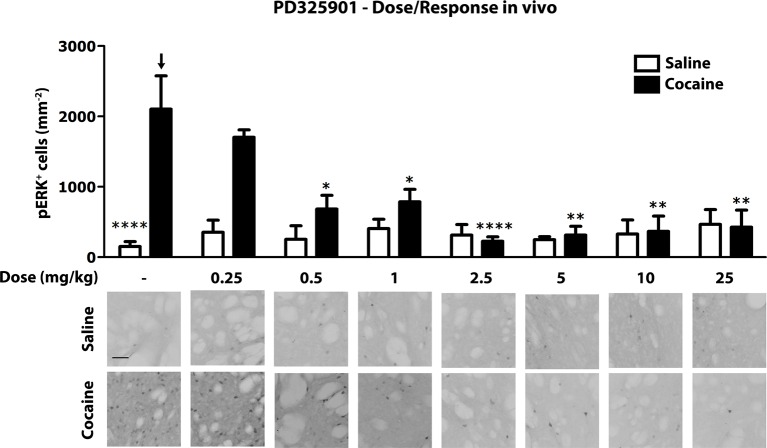
Dose response curve of MEK inhibitor PD325901 on ERK phosphorylation in vivo.Different doses of PD325901 were administered i.p. to wild-type mice 1 hr before the saline or cocaine (25 mg/kg) injection. After 5 min mice were perfused. Immunohistochemistry was performed with anti-phospho p44/42 MAP kinase (Thr202/Tyr204, lower panel, scale bar 30 μm). Quantification of phospho-ERK positive cells in the dorsal striatum (upper panel, mean with SEM) shows that PD325901 inhibited ERK in a dose-dependent manner. Two-way ANOVA, effect of PD325901 F7,78 = 2.43, p<0.05, effect of cocaine F1,78 = 4.81, p<0.05, effect of interaction F7,78 = 3.47, p<0.01; Bonferroni’s post-hoc, vehicle saline (n=9) vs vehicle cocaine (n=15) p<0.0001, vehicle cocaine (n=15) vs PD325901 0.25 mg/kg (n=4) p>0.05, vehicle cocaine (n=15) vs PD325901 0.5 mg/kg (n=5) p<0.05, vehicle cocaine (n=15) vs PD325901 1 mg/kg (n=5) p<0.05, vehicle cocaine (n=15) vs PD325901 2.5 mg/kg (n=15), p<0.0001, vehicle cocaine (n=15) vs PD325901 5 mg/kg (n=5), p<0.01, vehicle cocaine (n=15) vs PD325901 10 mg/kg (n=5), p<0.01, vehicle cocaine (n=15) vs PD325901 25 mg/kg (n=5), p<0.01. *p<0.05, **p<0.01, ****p<0.0001, all the statistical significances are referred to the vehicle cocaine group indicated by the arrow. Data are shown as mean with SEM.